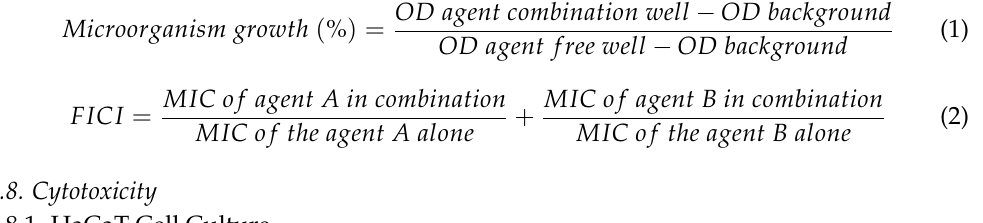
Figure 2. Schematic representation of the final concentration distribution in each 96-well microtiter plate in checkerboard assay. First, the organic molecules (Amz, AzoIz, AzoIz.DMA, or AzoIz.Pip) were serially diluted (green and yellow), and then, in the same plate, the AgNPs (stabilized in citrate or PVP) were added and serially diluted (blue). MIC of organic molecules can be calculated from columns 1 and 7, and MIC of AgNPs can be calculated twice from raw H.